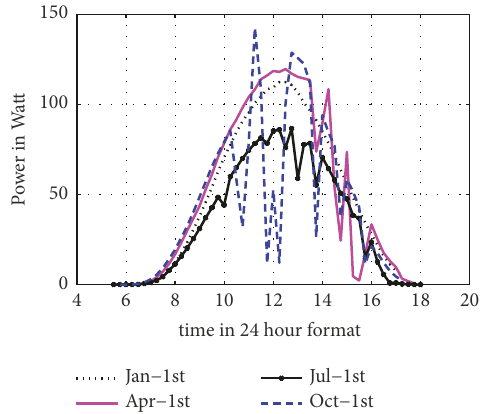
Figure 14: Hourly variation of power output of Kyocera 200GT PV module for 2 Ω resistance.